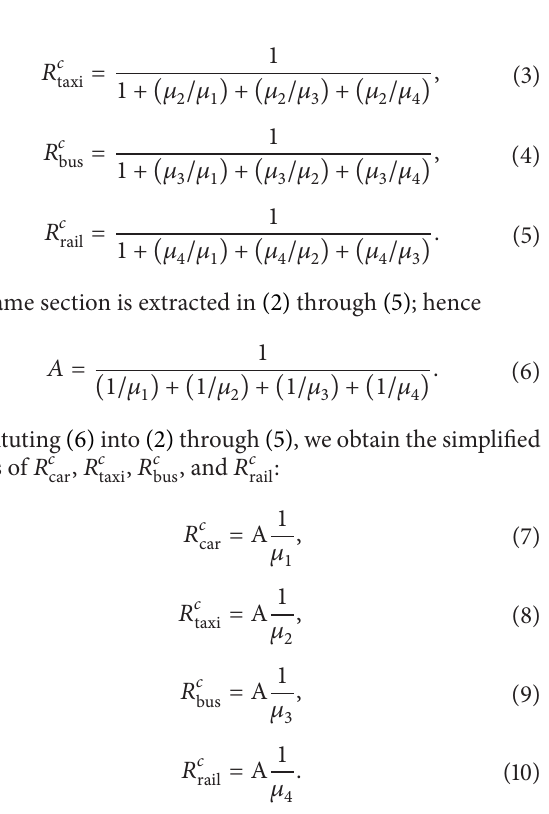
Figure 3: Noncar Owner Travel Mode Choice